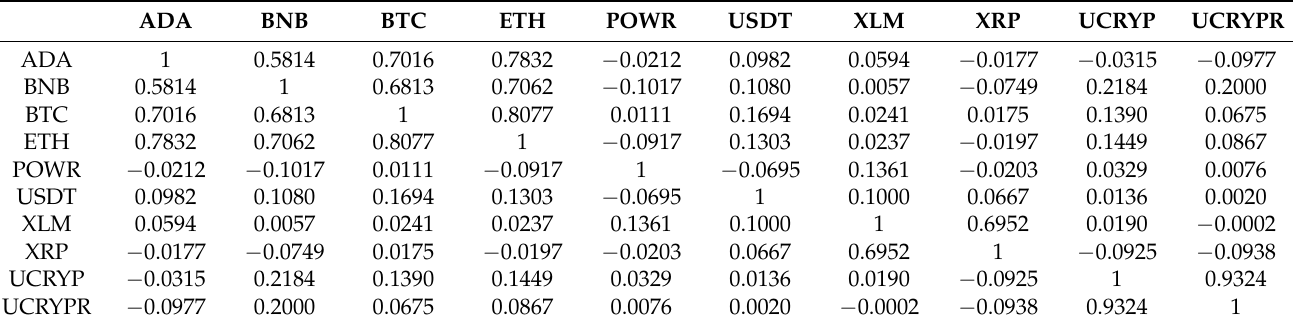
Table 2. Unconditional